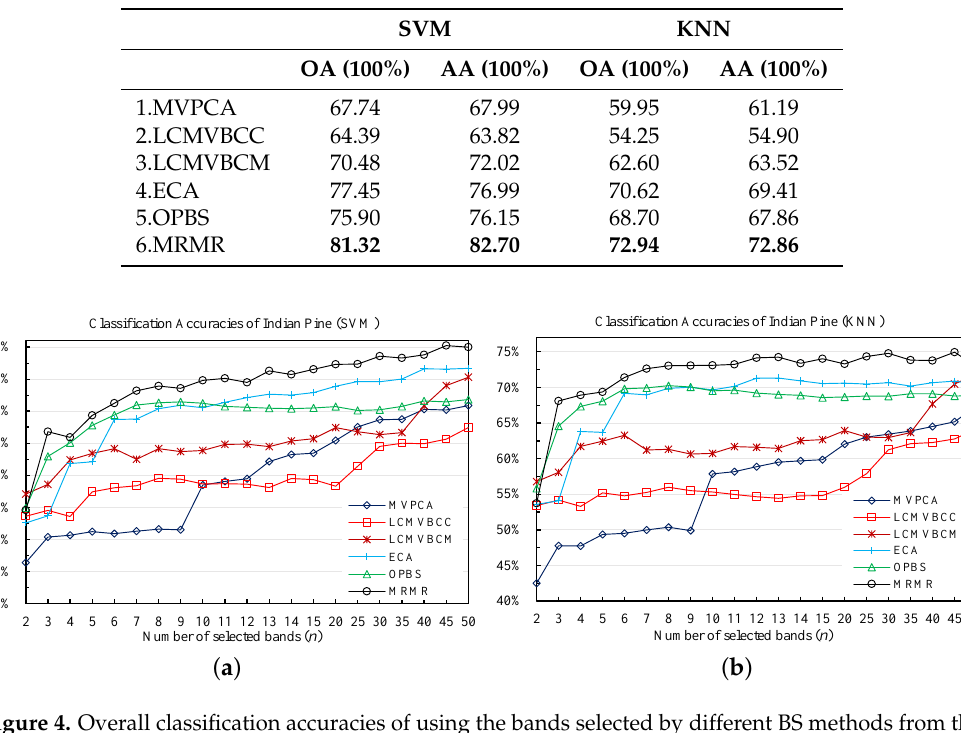
Figure 4. Overall classification accuracies of using the bands selected by different BS methods from the Indian Pine dataset. ( a ) SVM ( b )